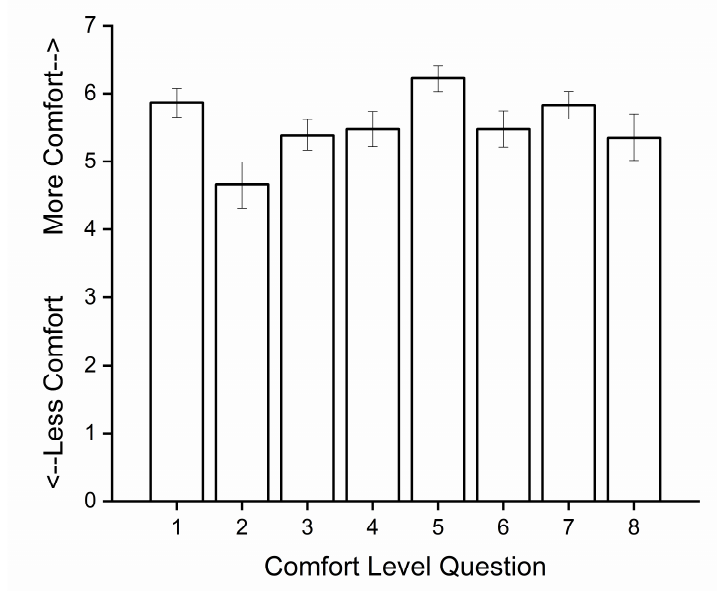
Figure 2. Effect of study segment (baseline vs. chronic sleep restriction-forced desynchrony (CSR-FD)) on happy–sad visual analog scale scores. The combined data from young and older participants are plotted for the baseline ( ○ ) and for each chronic sleep restriction-forced desynchrony (CSR-FD) day (●). The baseline mean (single point) is the average from the three baseline days. For each CSR-FD day, a daily average for each participant was first calculated and then those were averaged across participants.